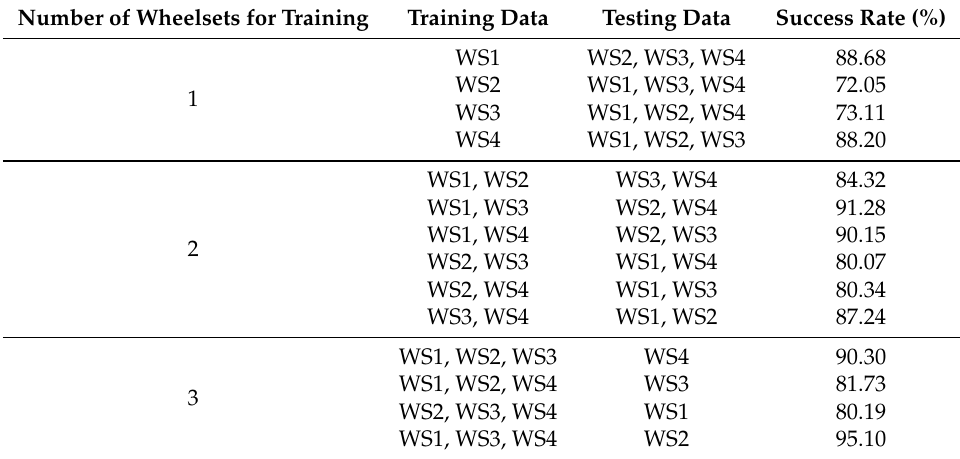
Table 7. Packets selected as the best features and the related frequency